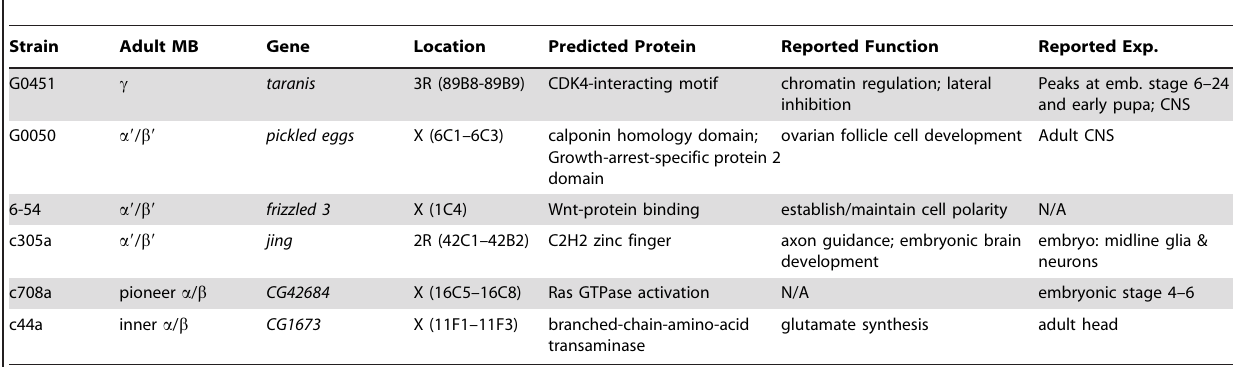
Table 1. Novel genes expressed in adult mushroom